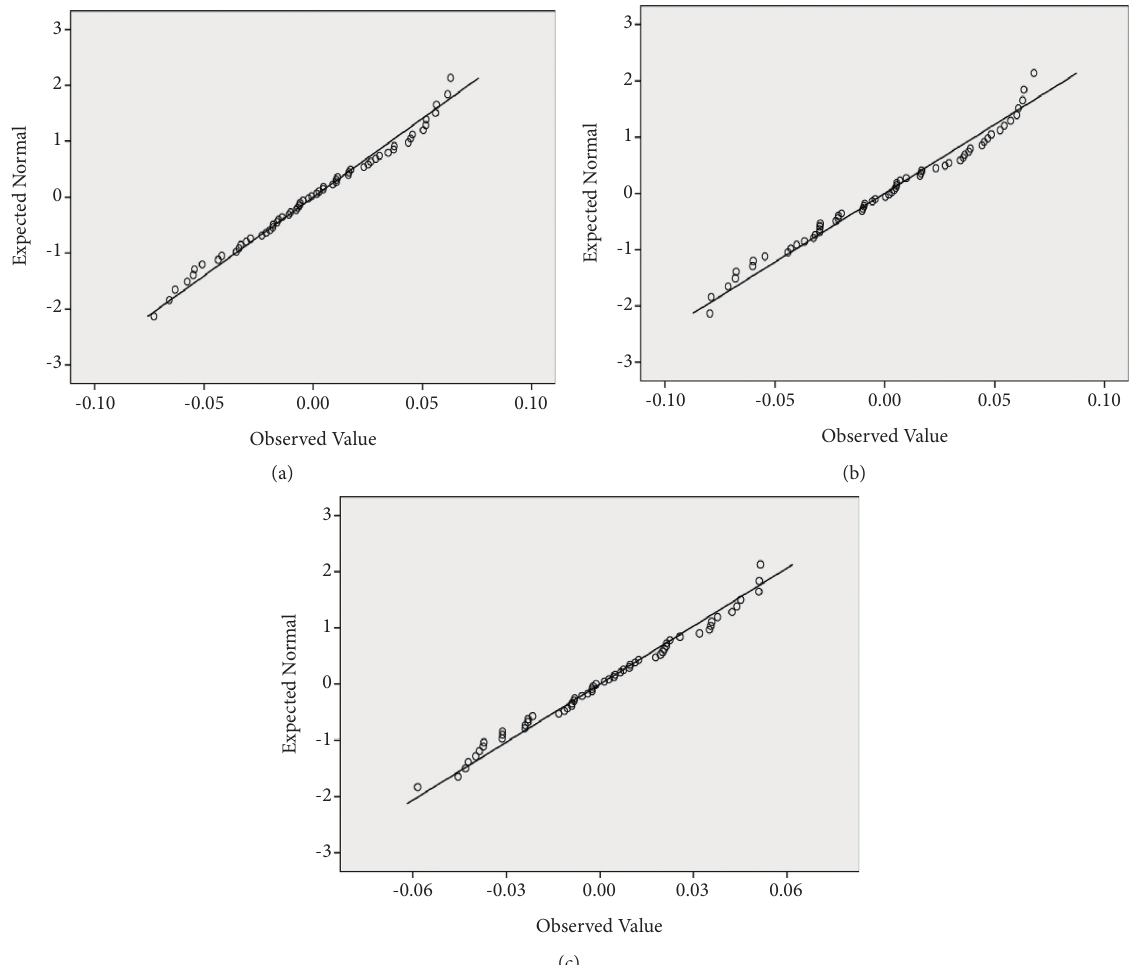
Figure 29: Residual Q-Q diagram of the maximum lateral acceleration model in the simple horizontal curve. (a) Sedan. (b) SUV. (c) Truck.